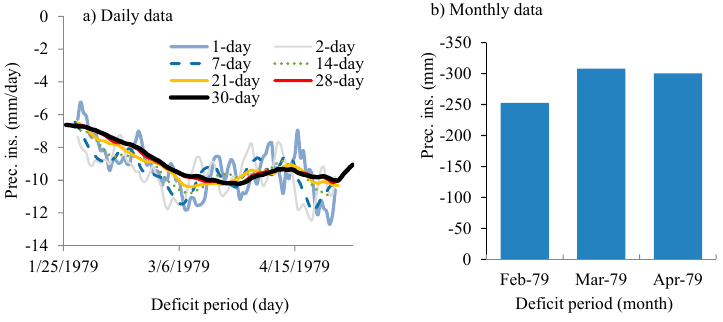
Figure 5. Selected drought event based on the catchment-wide: ( a ) daily; and ( b ) monthly ( H ) precipitation insufficiency (Prec. ins.) from 1979–2000.